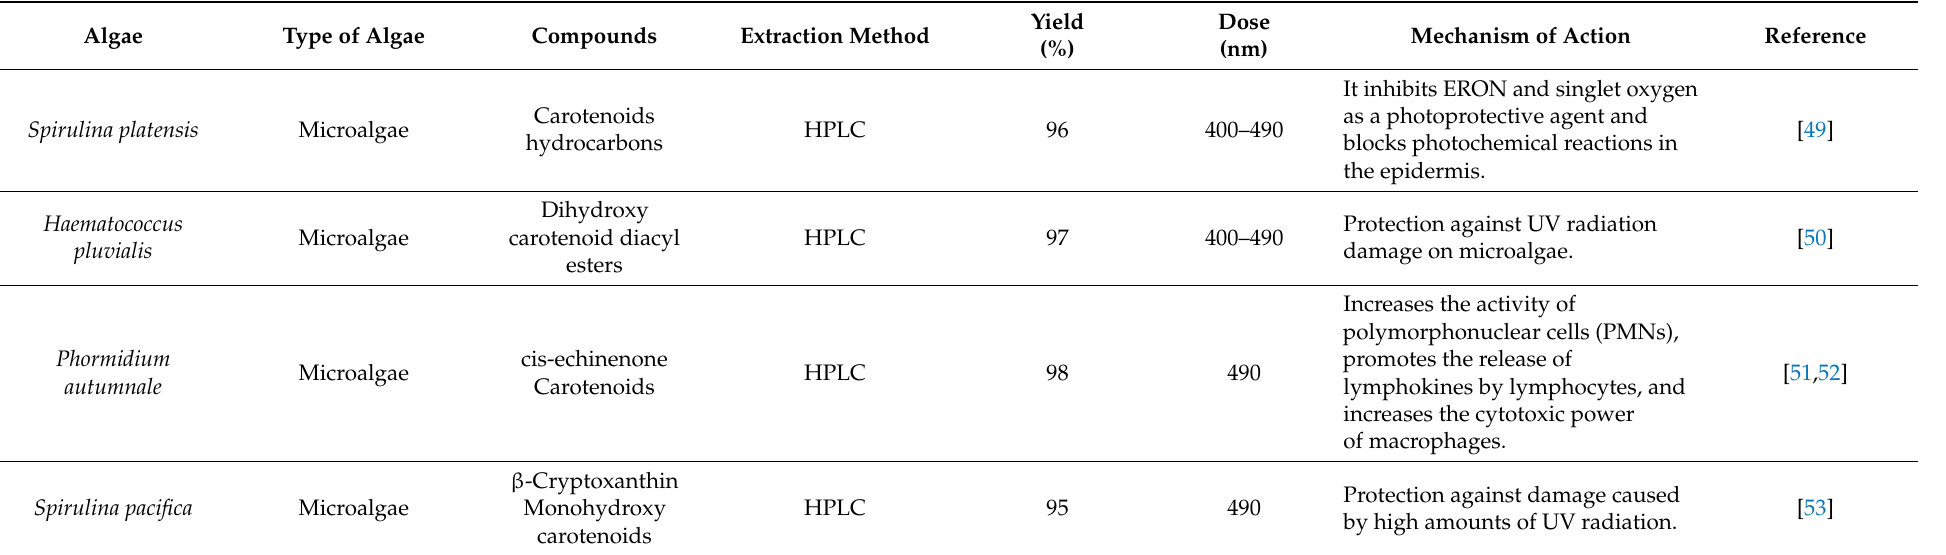
Table 4. Algae compounds obtained by UV-vis radiation